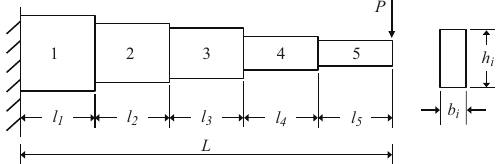
Figure 8. Configuration of a stepped cantilever